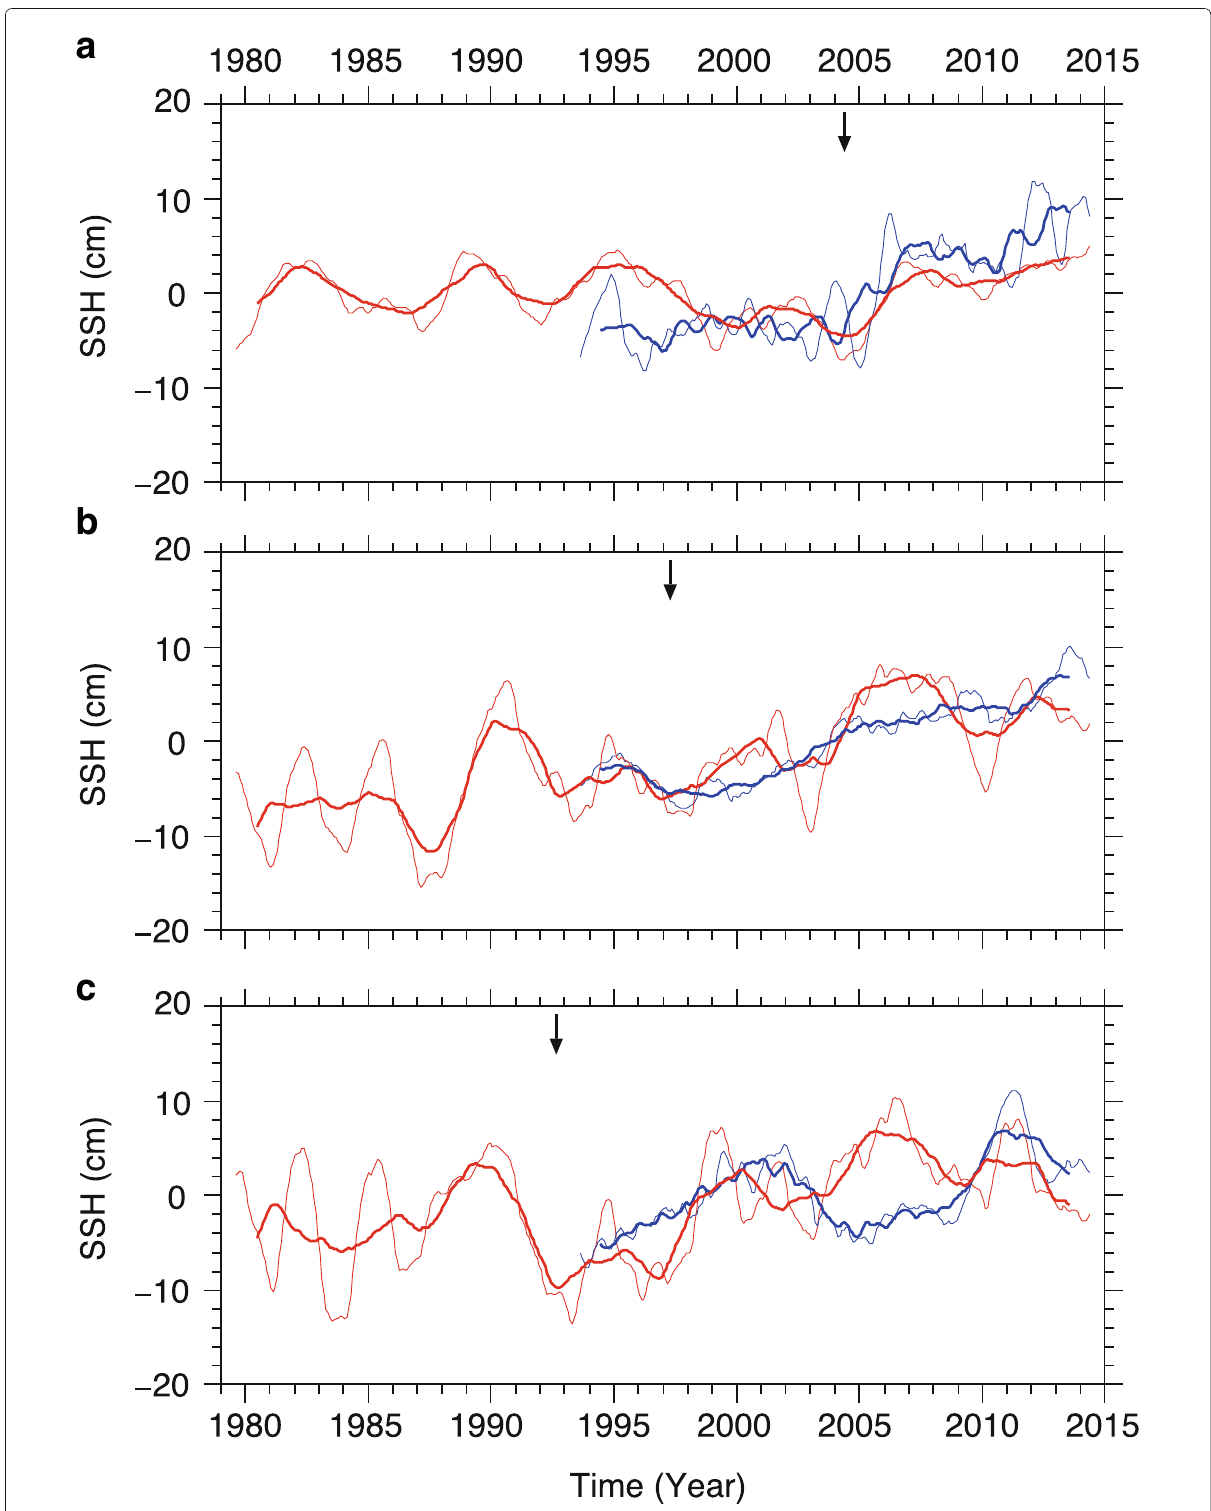
Fig. 8 Wind-driven (red lines) and altimetry-based (blue lines) variations in SSH at stations a K1, b K2, and c east of KNOT. Smoothed time series by 15- and 35-month running mean filters are denoted by thin and thick lines, respectively. Arrows show estimated times at the latitudes when SSH began to increase due to the WSAG